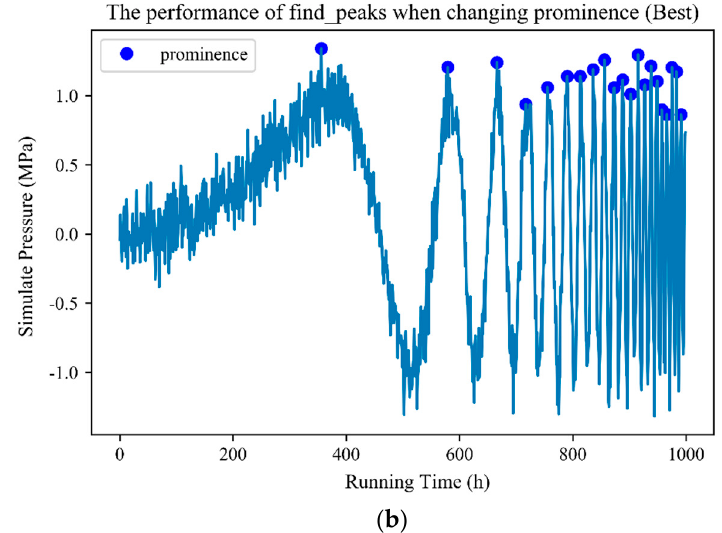
Figure 4. Diagram of ( a ) distance- and ( b ) prominence-based wave detection algorithm to capture peaks in pressure changes.